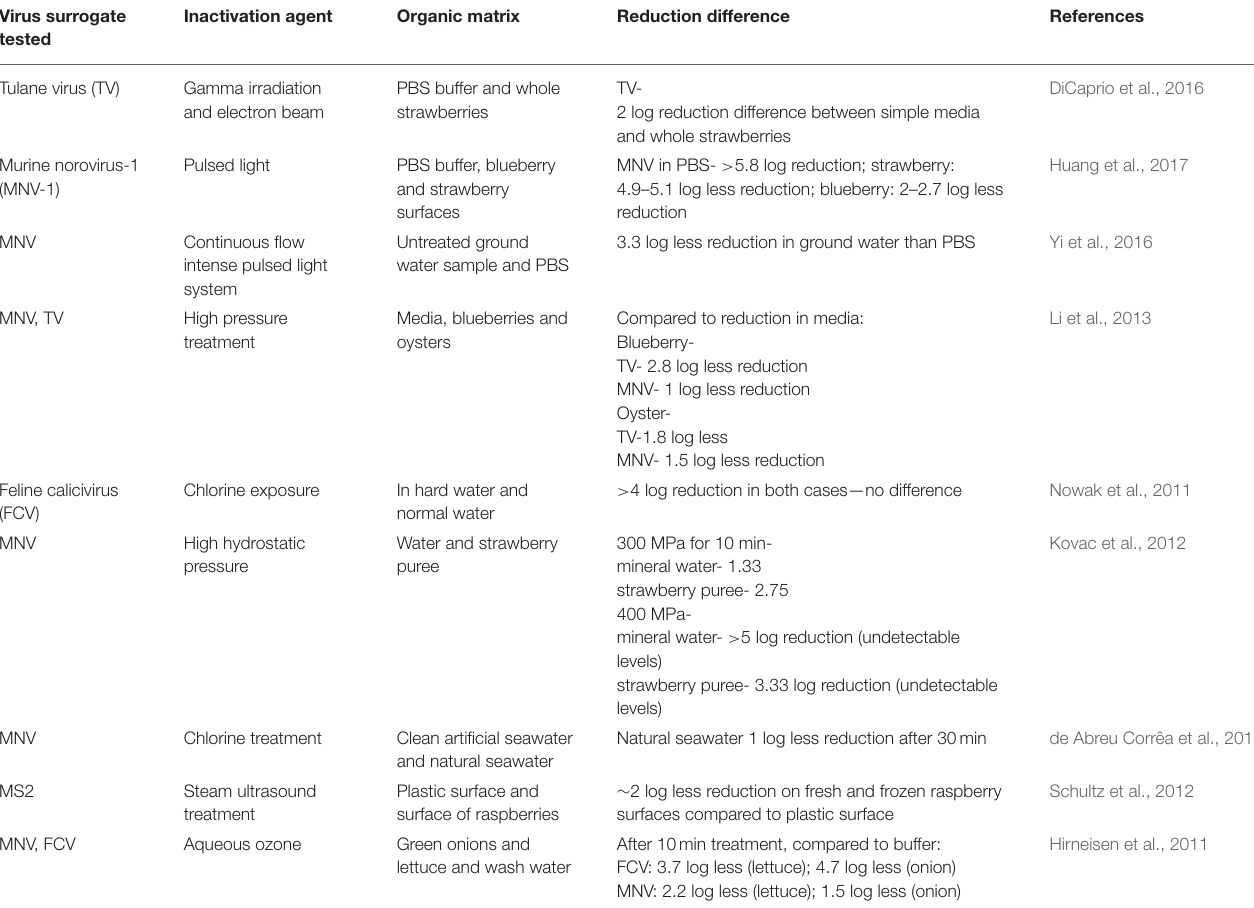
TABLE 2 | Effect of organic load and food matrices on inactivation of human norovirus surrogates subjected to various treatments. Virus surrogate